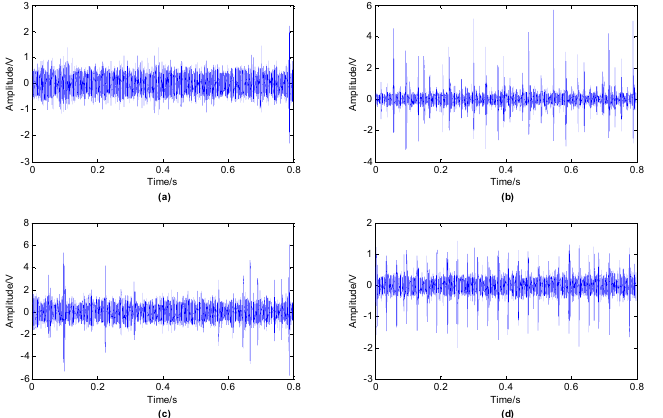
Figure 3. Vibration signals corresponding to different running statuses: ( a ) Normal; ( b ) inner race fault; ( c ) rolling element fault; ( d ) outer race fault.